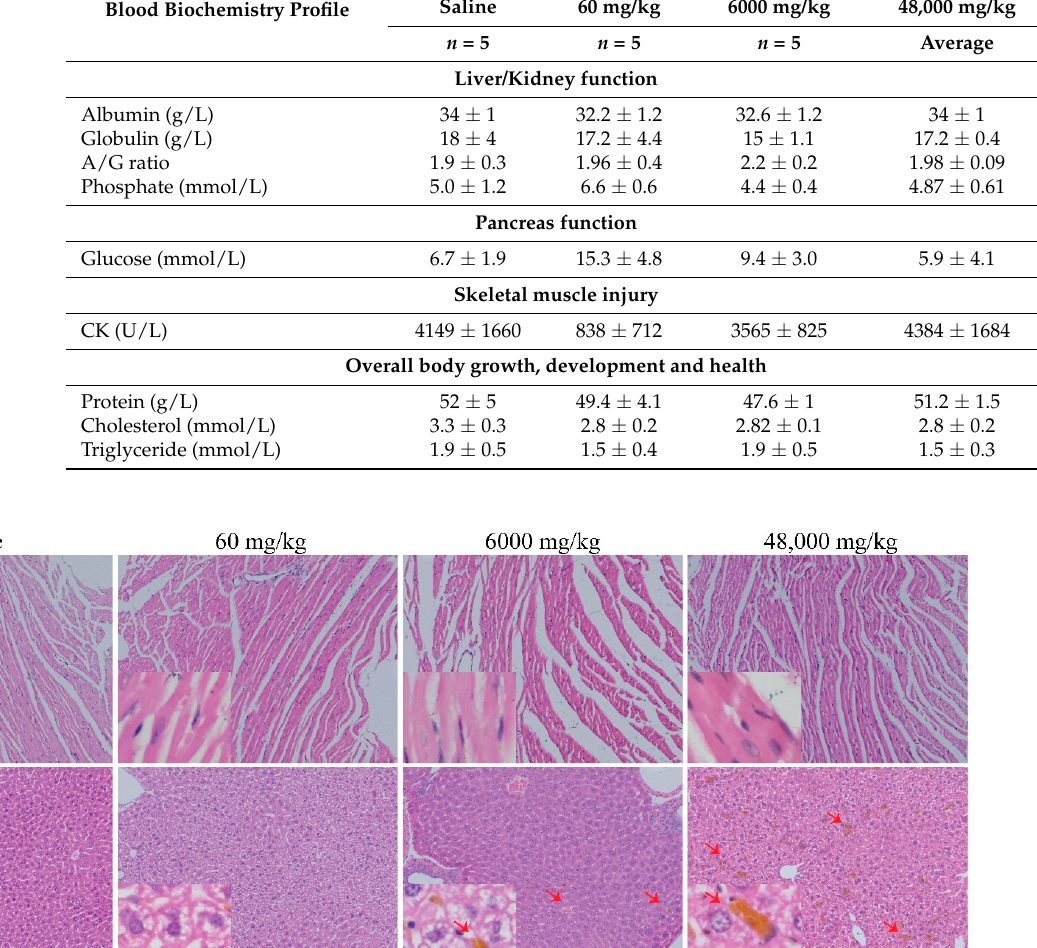
Table 5. Blood biochemical serum parameters in BALB/c mice following 14 days of repeated IV administration of the PPNs (repeated doses). The data are expressed as mean ± standard deviation ( n = 5).